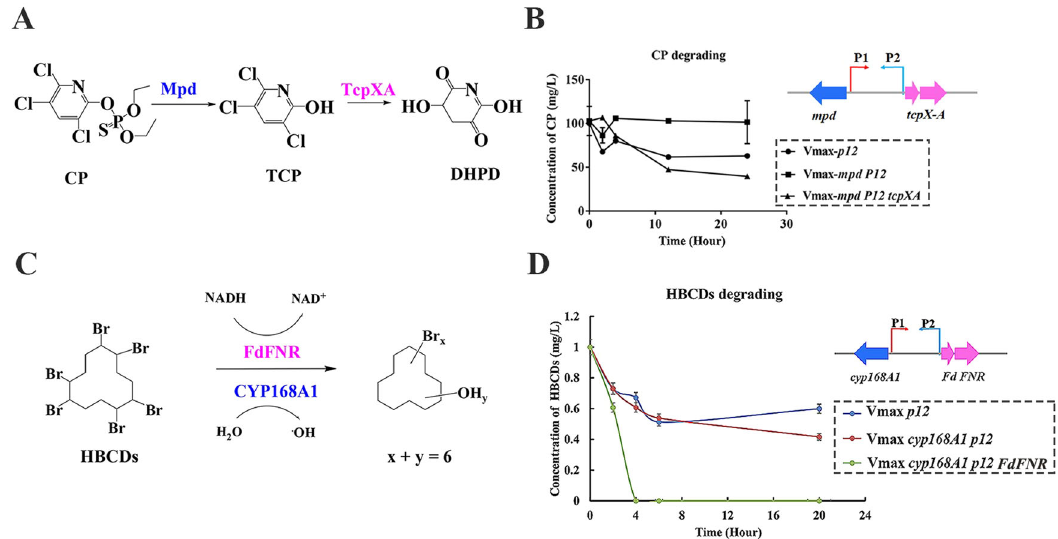
Fig. 3 Construction and characterization of the salt-induced model with promoters P1 and P2-1. a Research basis of chlorpyrifos (CP) degradation and the plasmid diagram for salt-induced CP degradation. b Veri fi cation of the metabolic ef fi ciency of the pesticide CP. c Research basis of hexabromocyclododecane (HBCD) degradation and the plasmid diagram for salt-induced HBCD degradation. d Veri fi cation of the metabolic ef fi ciency of the